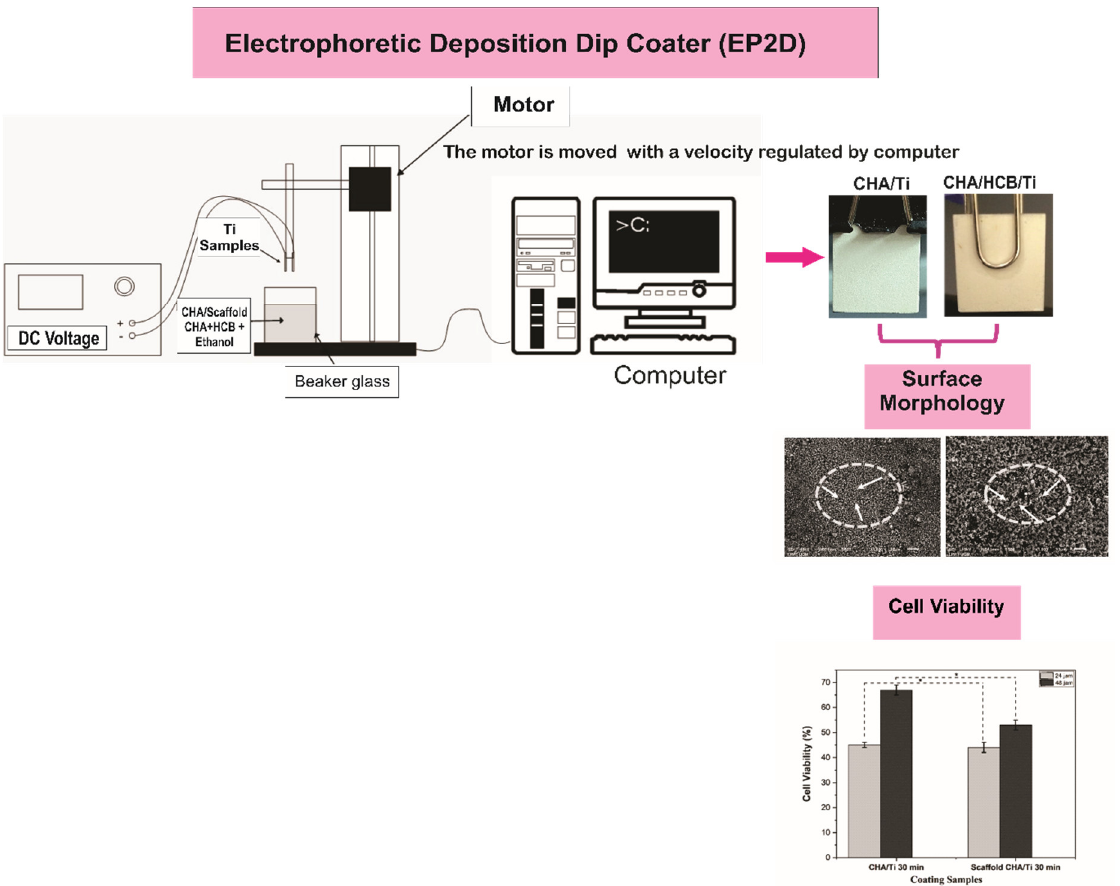
Figure 1. The schematic design used for the coating procedures (modification from [7]).